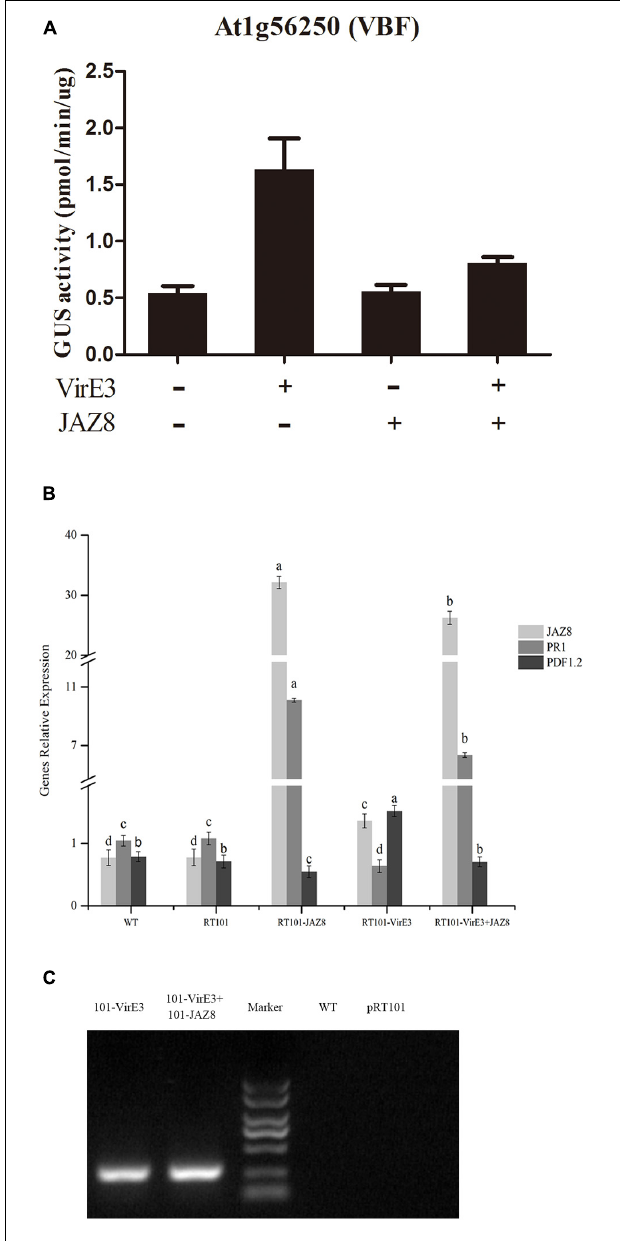
FIGURE 3 | Protoplast expression analysis of the promoters of At1G56250 ( VBF ) and the gene expression analysis of PR1 , PDF1.2 , JAZ8, and virE3 . (A) JAZ8 inhibits VirE3-dependent activation of the At1G56250 ( VBF ) (857 bp) promoters in Arabidopsis protoplasts. (B) qPCR analysis of the expression level of PR1 , PDF1.2 , JAZ8 in protoplasts transfected with corresponding plasmids. (C) RT-PCR analysis of the expression of virE3 in protoplast transformed with corresponding